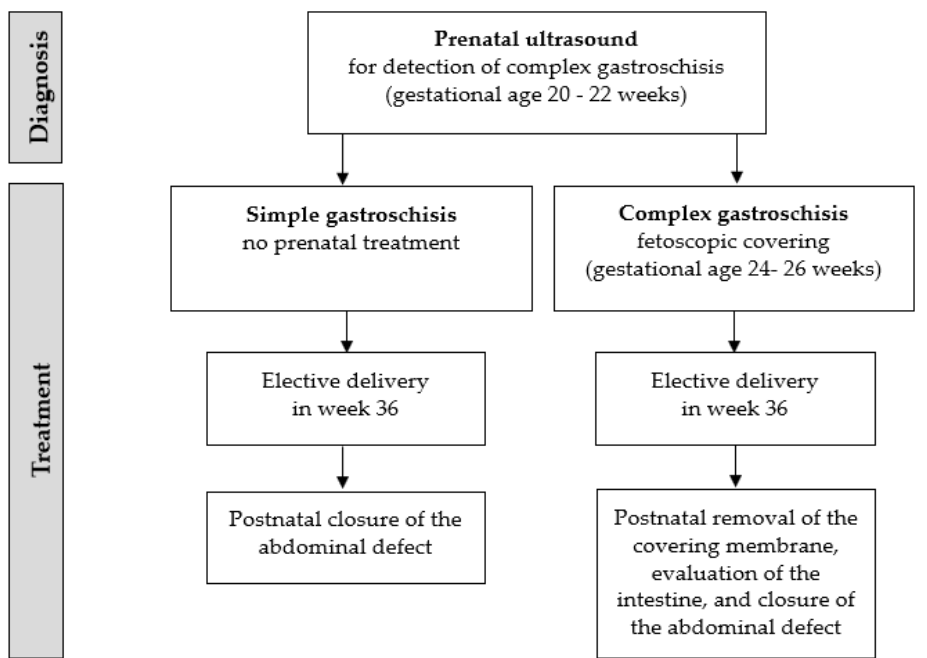
Figure 2. The algorithm for fetal management of gastroschisis.